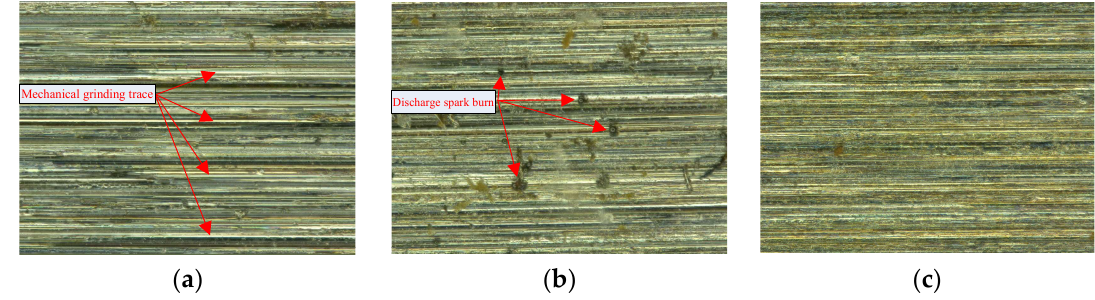
Figure 12. Comparison of three machined surface topographies: ( a ) internal cylindrical ordinary grinding; ( b ) internal cylindrical ECG; ( c ) ICUAECG.